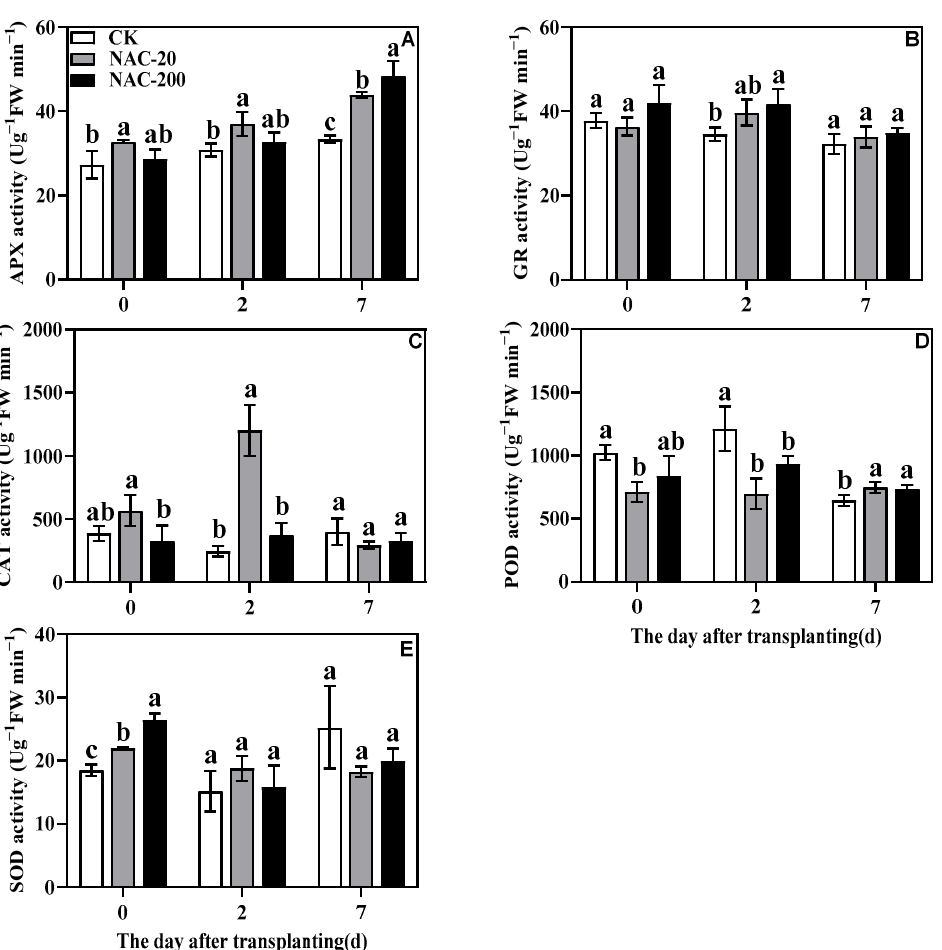
Figure 7. Effects of different concentrations of NAC on APX ( A ), GR ( B ), CAT ( C ), POD ( D ), and SOD ( E ). CK, 0 µ m; NAC-20, 20 µ m; NAC-200, 200 µ m. Data are means ± SD ( n = 3). The different letters following average values indicate significant difference (Duncan, p < 0.05).